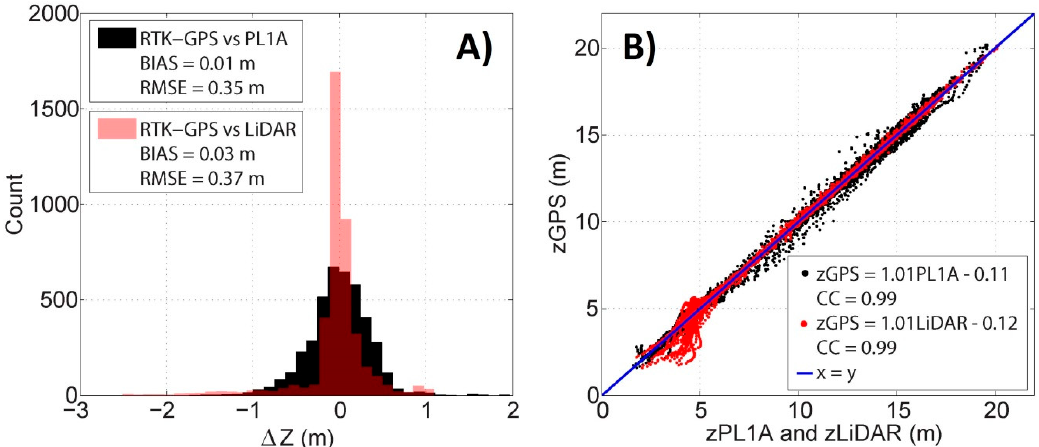
Figure 2. Pleiades (PL1A) and LiDAR survey accuracy assessed by comparison to concurrent on-ground